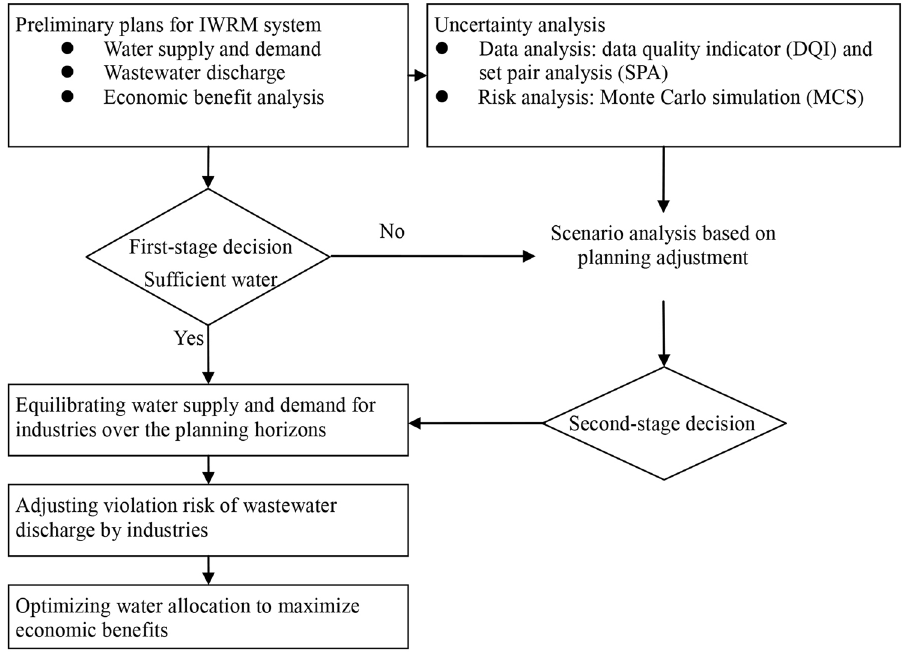
Figure 6. Industrial water resources management framework.